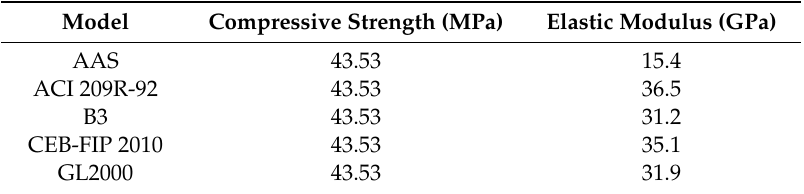
Table 3. Elastic modulus of model calculation.